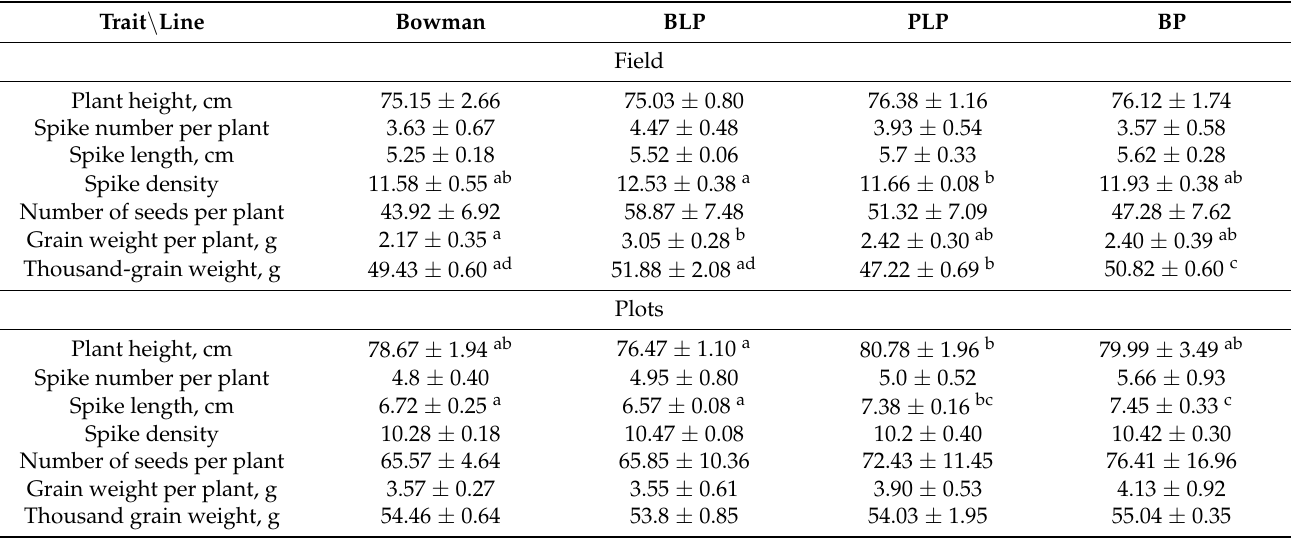
Table 1. Characteristics of the lines with different combinations of anthocyanin and melanin pigments. Different letters within a row indicate statistically significant differences between the lines ( t test, p <